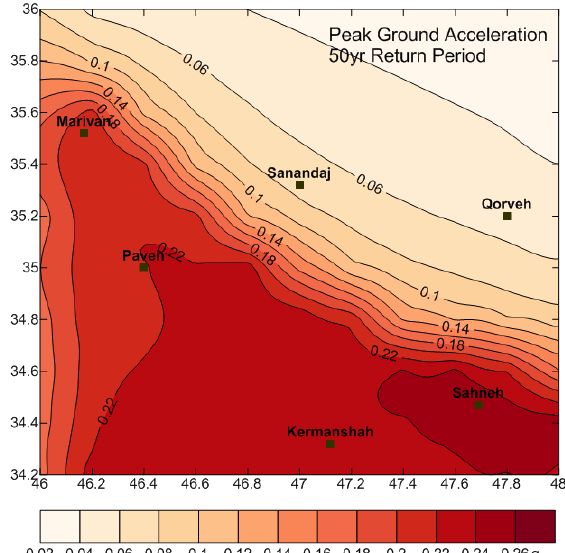
Figure 3. Seismic hazard map of the Kermanshah-Sanandaj region in terms of PGA for the 50-year return period.